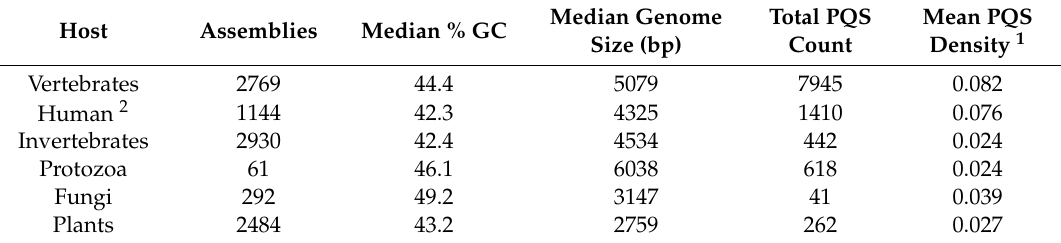
Table 3. Genome metrics and quadruplex sequences classified by host